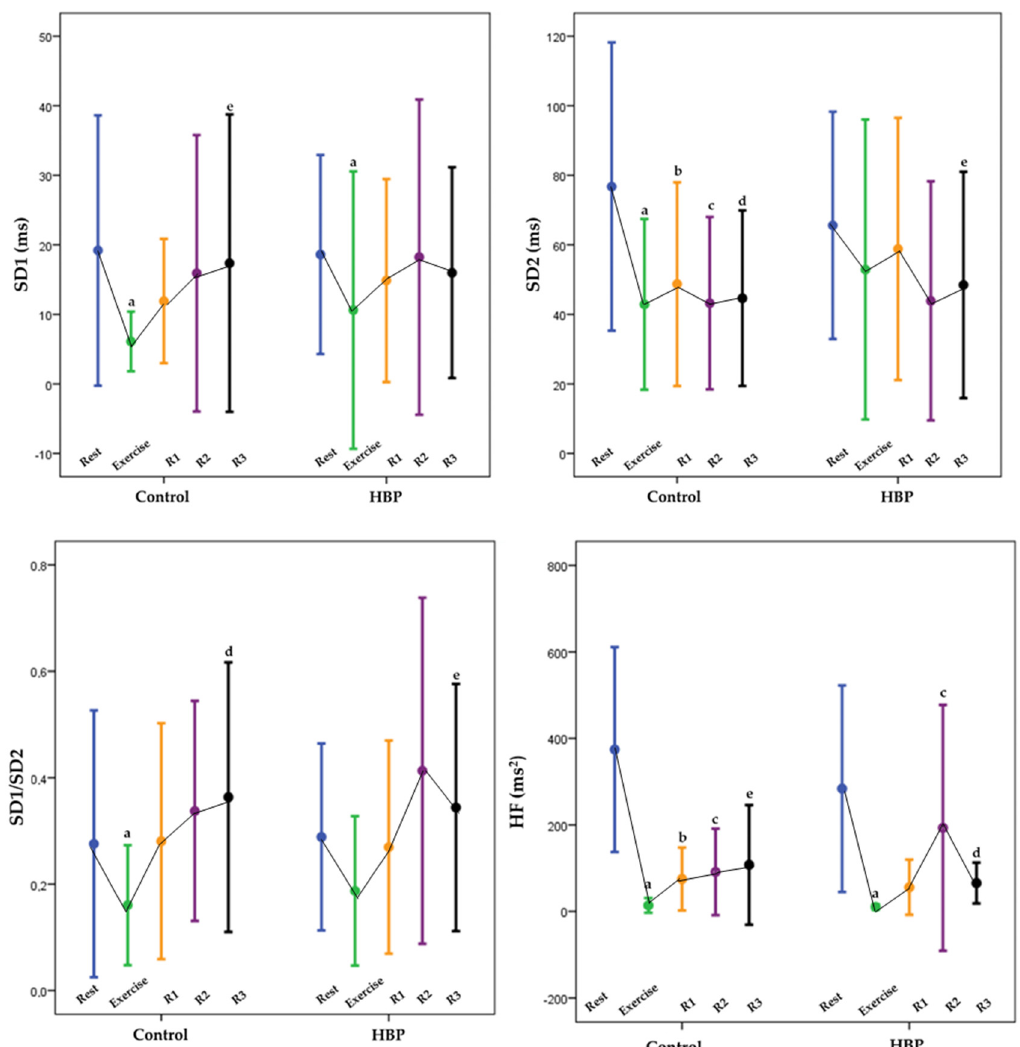
Figure 3. Comparative analysis of HRV (SD1, SD2, SD1/SD2 and HF) during rest, aerobic exercise, and recovery. MANOVA test (Mean ± SD), HBP (high blood pressure group), control (control group), (R1) recovery period 1—first 5 min of the recovery period, (R2) recovery period 2—between the 10th and 15th min of the recovery period, (R3) recovery period 3—between the 25th and 30th min of the period recovery, (SD1) standard deviation of the variability instantaneous beat-to-beat or dispersion of points perpendicular to the line of identity, (SD2) standard deviation of long-term continuous RR intervals or dispersion of points along the line of identity, (SD1/SD2) ratio scatter of points perpendicular to the dispersion line identity of dots along line identity, percentage of adjacent RR intervals with a difference of duration greater than 50ms, (%) percentage, and (HF) high frequency component. (a) Post hoc test found differences when comparing rest with exercise, (b) post hoc test found differences when comparing rest with R1, (c) post hoc test found differences when comparing rest with R2, (d) post hoc test found differences when comparing rest with R3, and (e) post hoc test found differences when comparing R1 with R3.